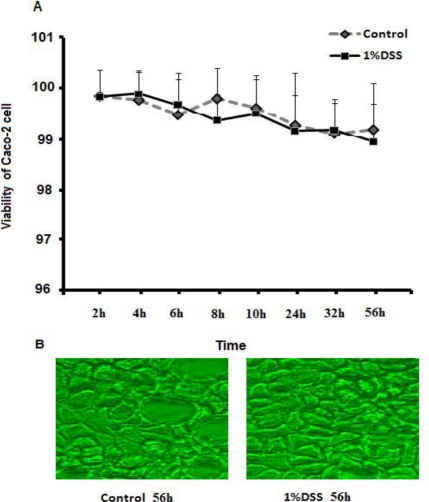
Incubation of Caco-2 with dextran sulfate sodium (DSS) does not affect viability or morphological characteristics of Caco-2. (A) Numbers of viable cells were determined using the trypan blue dye exclusion method. Percent viability was expressed as the percentage of growth compared to total cells at each time point; (B) Images of Caco-2 cells using microscopy at 40× were acquired using an Olympus digital camera. Each time point for both treated and untreated groups represents the mean of four determinations.